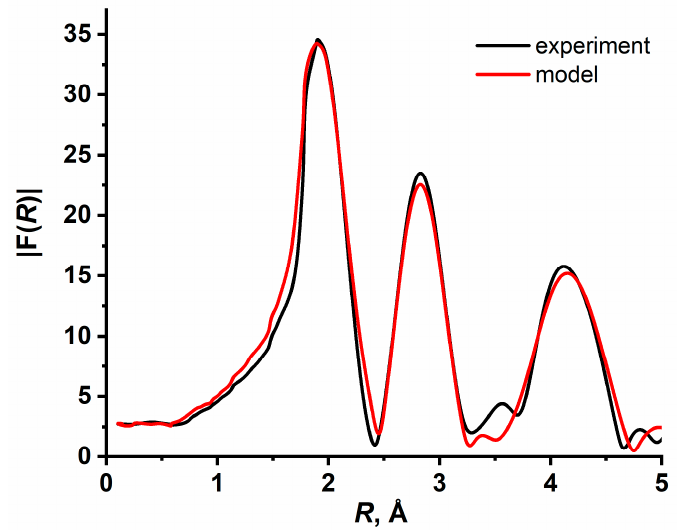
Figure 3. Comparison of the experimental and model radial distribution function for complex [FeL 2 ]B 10 H 10 ·H 2 O.